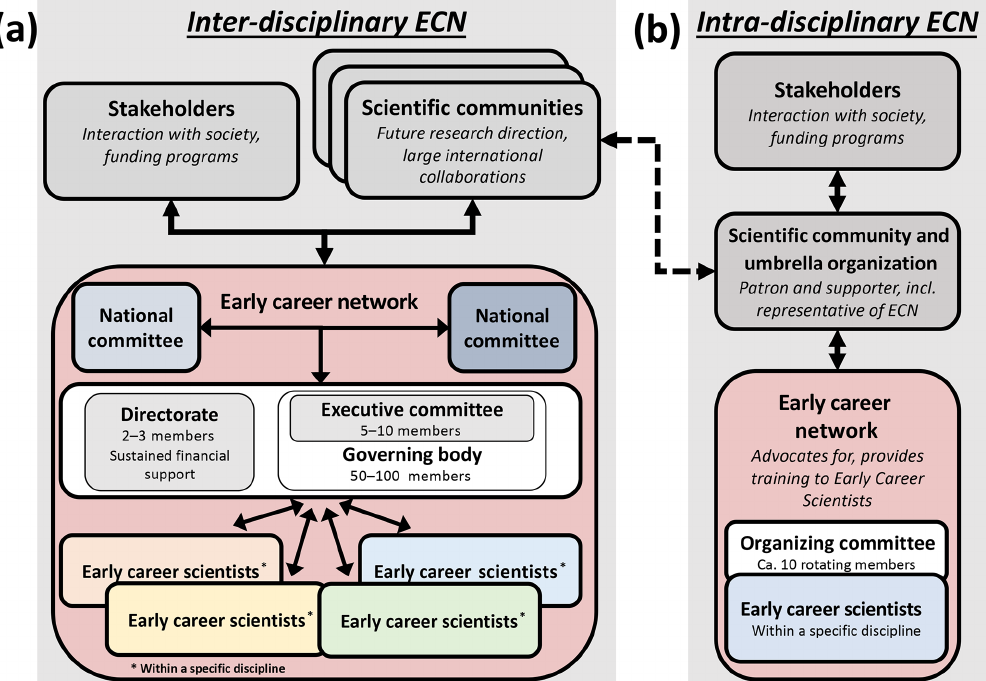
Figure 1. Schematic overview of organizational structure for inter-disciplinary (e.g. APECS) and intra-disciplinary ECN (e.g. ICYS), shown in (a) and (b)